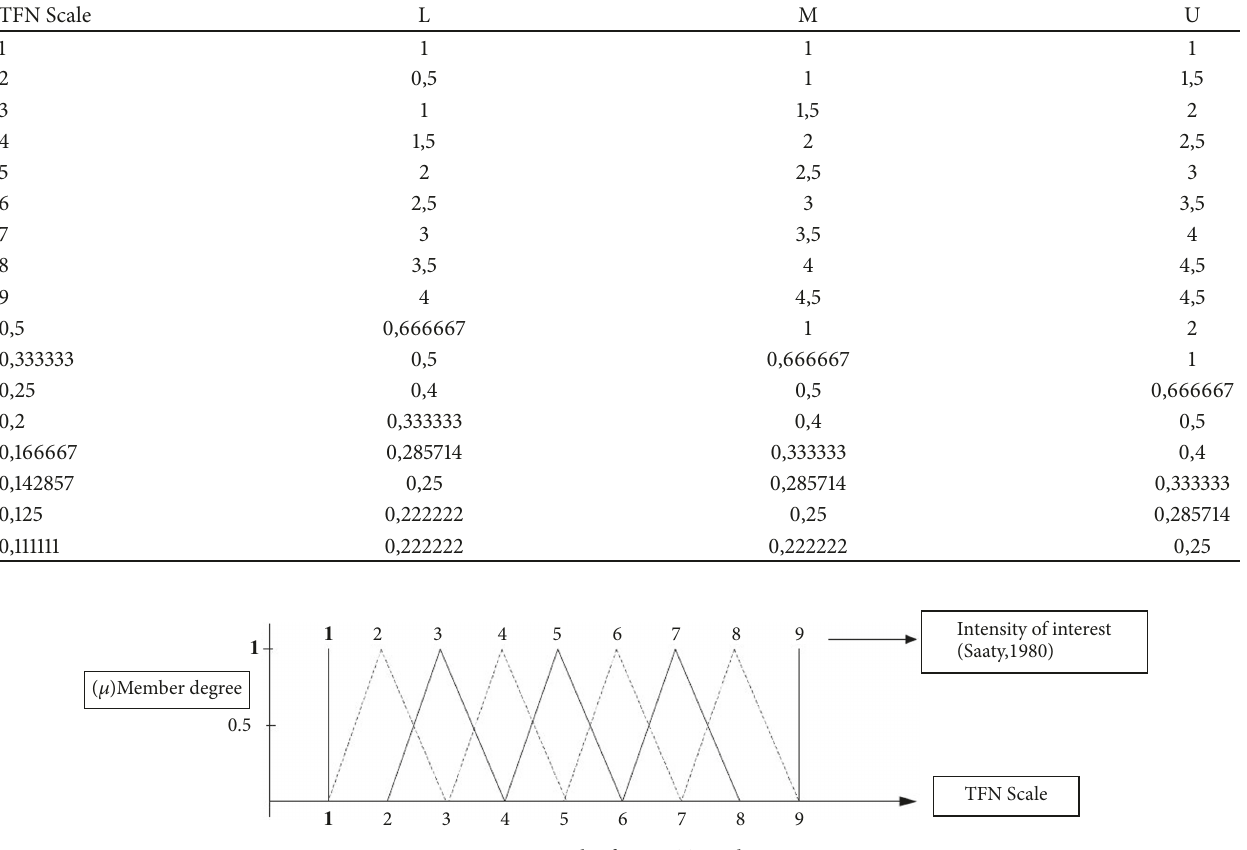
Figure 2: Graph of Fuzzy Triangle